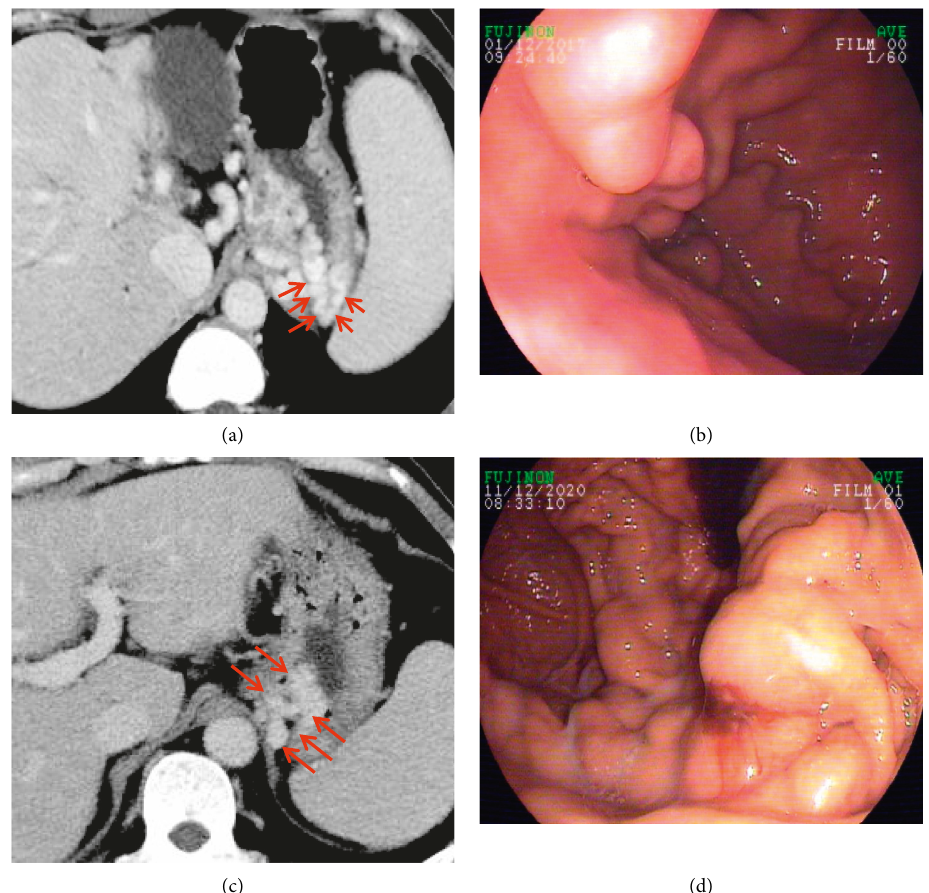
Figure 5: Gastric varices. In a 47-year-old female and a 56-year-old male with liver cirrhosis, the axial contrast-enhanced CT scan on the portal vein phase demonstrated that gastric varices (red arrow) were long, nodular, and tortuous enhanced channels at the gastric fundus. Upper gastrointestinal endoscopy showed dilated and tortuous varices at the gastric fundus. Note: (a, b) the contrast-enhanced CTscan and endoscopy of a 47-year-old female, respectively; (c, d) the contrast-enhanced CT scan and endoscopy of a 56-year-old male, gastroesophageal variceal bleeding than those with the left portal vein, splenic vein, splenoportal vein angle, or left gastric vein draining into the splenic vein or splenoportal portal vein branch [58]. Patients with the left gastric vein vein junction [53]. On the portal vein phase of the contrast- draining into the main portal vein are more prone to cause